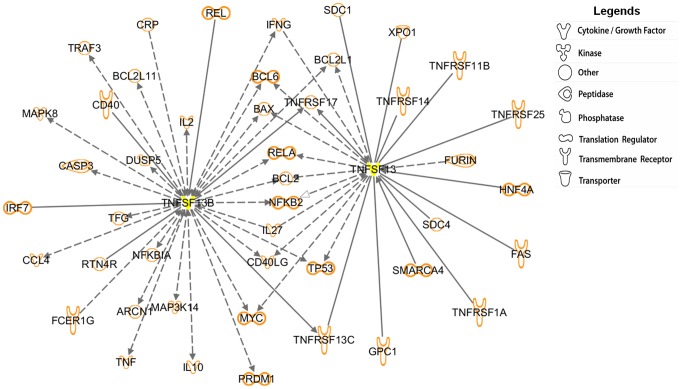
Identification of BAFF- and/or APRIL-related genes.Ingenuity Pathway Analysis (IPA) was used to identify the forty-five BAFF- and/or APRIL-related genes represented on the microarray. BAFF and APRIL (yellow marked genes) were found to interact with many genes that are involved in regulating apoptosis, transcription, the immune response and signal transduction. Among these genes, the T helper 1 (Th1)-related genes, such as IFN-γ, IL-2, IL-27 and TNF (namely, TNF-α), were identified to interact with BAFF and/or APRIL. These genes are presented by their common abbreviated names. According to their direct (solid lines) or indirect (dashed lines) action, these genes can establish contacts with BAFF and/or APRIL. Lines ending in black arrows indicate an activation pathway, and those ending in white arrows represent a translocation process. Lines joining two genes indicate binding.